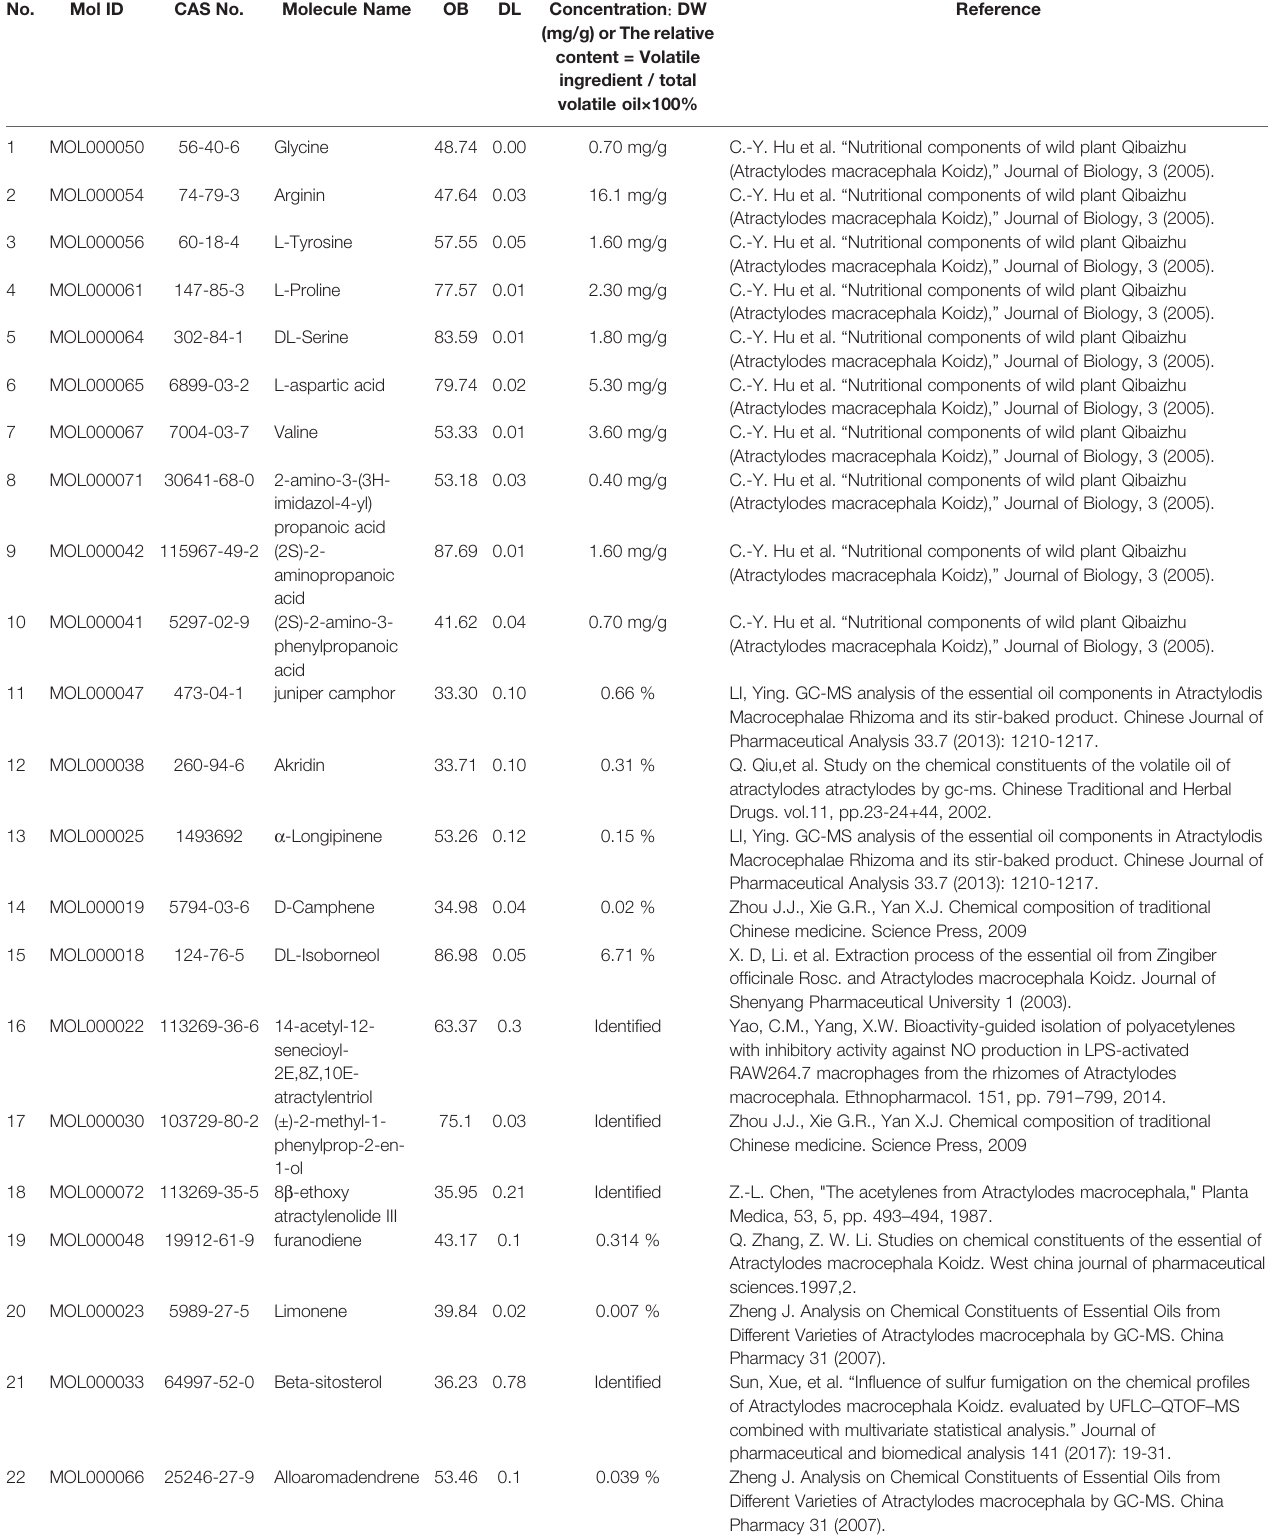
TABLE 1 | A total of twenty-seven ingredients were selected as the details of the active ingredients of AMK in this study. No. Mol ID CAS